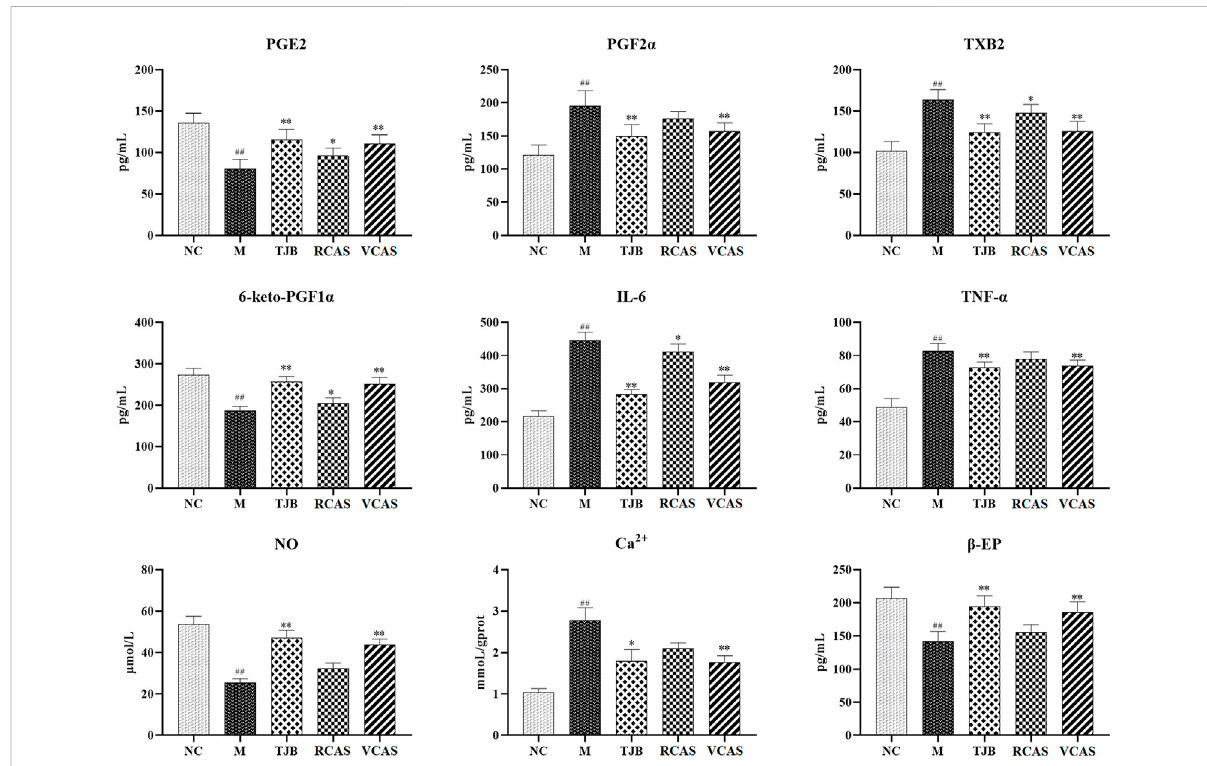
FIGURE 2 EffectsofRCASandVCASonpainfactorsinratswithprimarydysmenorrhea. ## and # representthecomparisonwiththeNCgroup: p < 0.01, p < 0.05; ** and * represent the comparison with the M group: p < 0.01 and p <